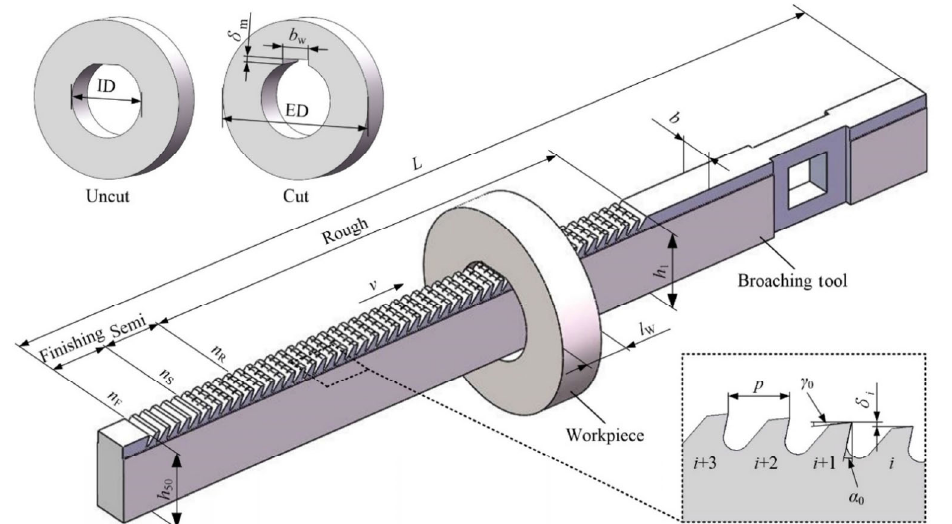
Fig. 2 Schematic diagram of tool and